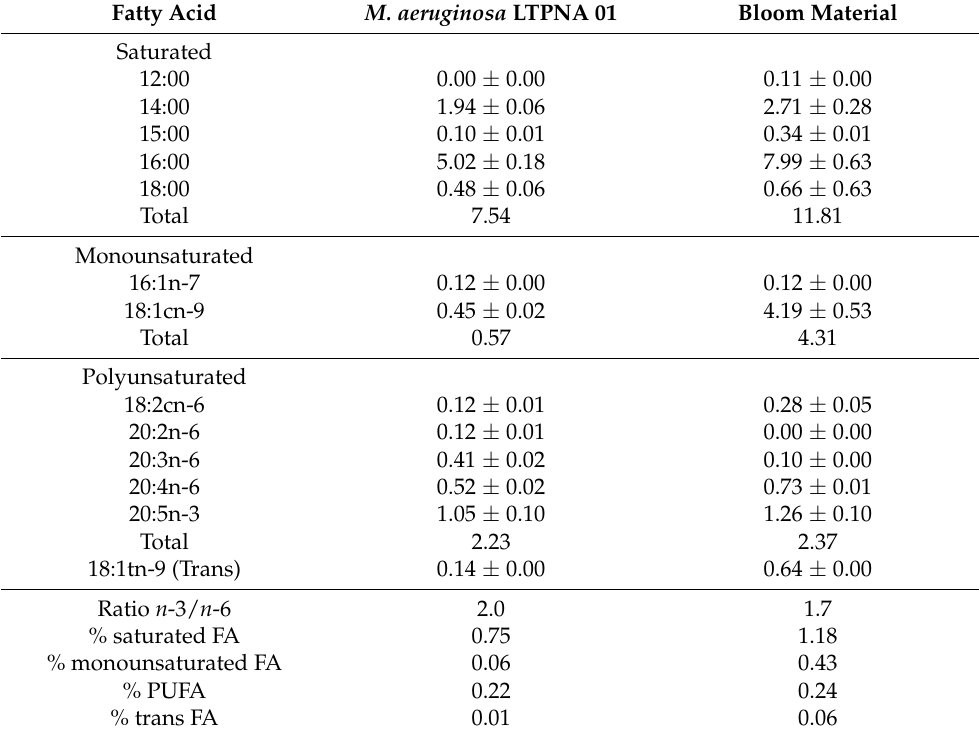
Table 2. M. aeruginosa LTPNA 01 and bloom material fatty acid composition (g/kg of dry weight, n = 5, average ± CV).